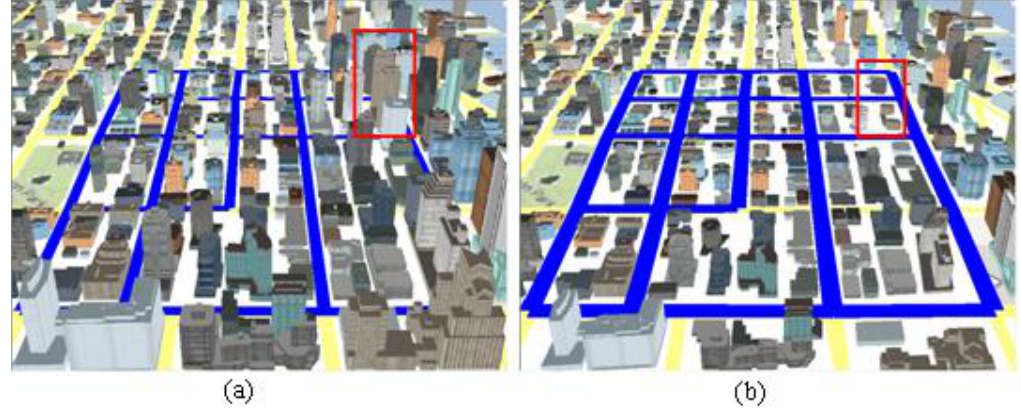
Figure 11. ( a ) An occlusion-free route network in Vancouver city; and ( b ) when the route is very complex, the buildings shown in the red rectangle may be over-scaled.